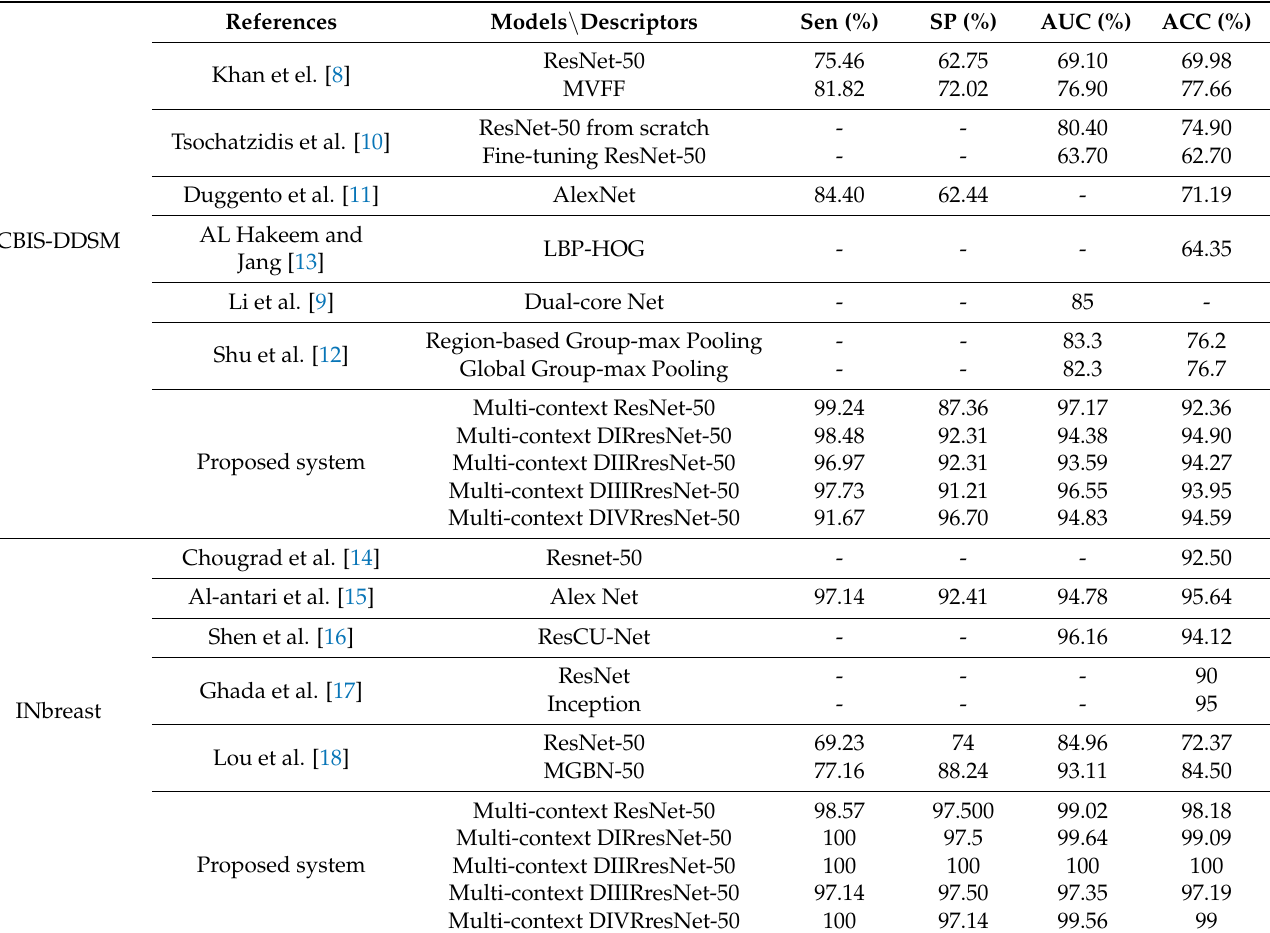
Figure 15. INbreast ROC curve for the effect of density-specific models and ResNet50. Table 10. The comparison with different state-of-the-art